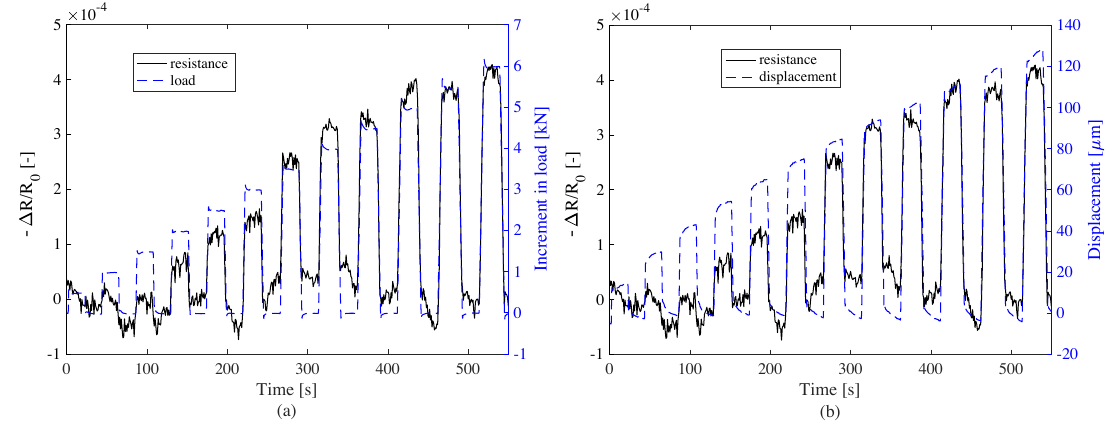
Figure 13. Postprocessed time histories of electromechanical test with increasing box loads: ( a ) change of resistance versus change of load; ( b ) relative resistance versus displacement of the top of the plate.